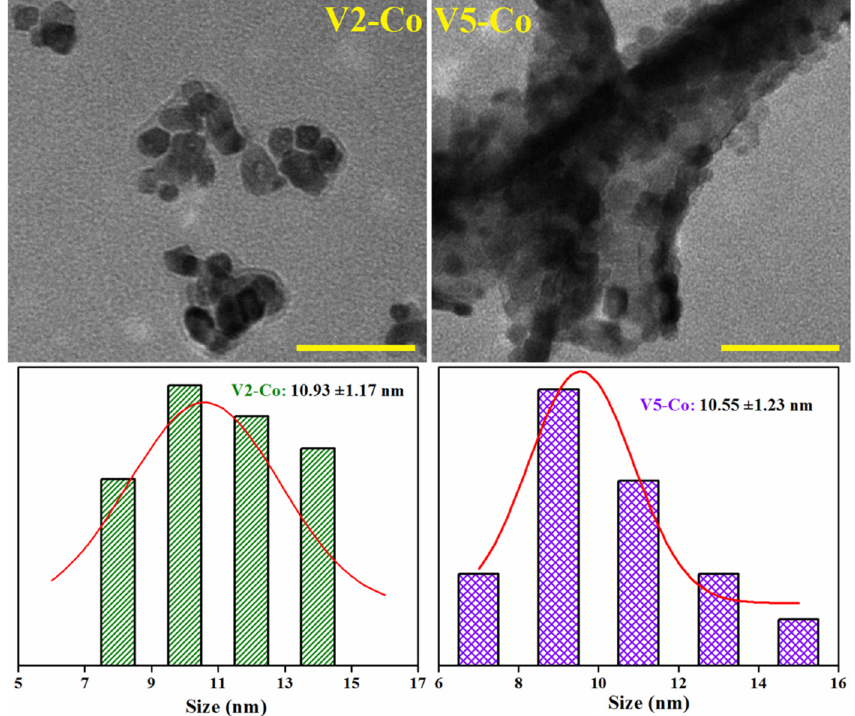
Figure 5. TEM images of Co-doped CeO 2 nanoparticles and the corresponding particle size distribution. Scale bar is 50 nm.